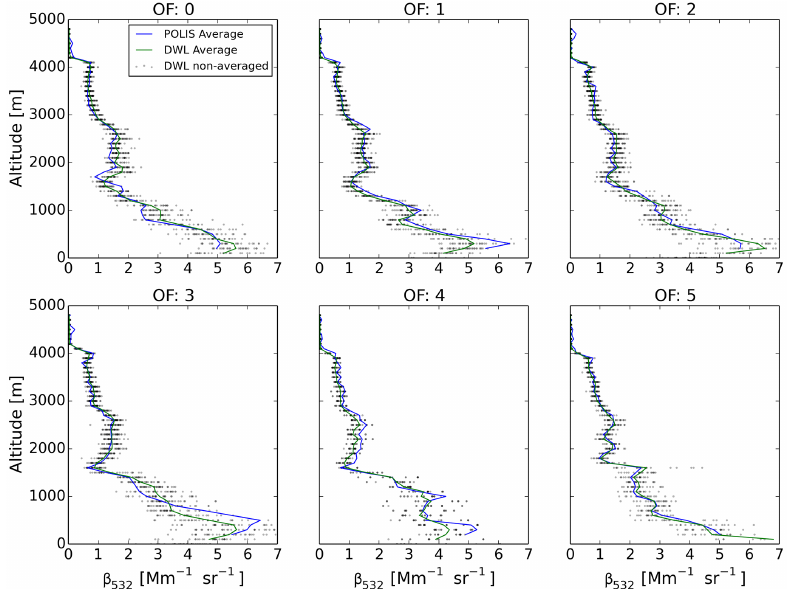
Figure 15. Comparison of the non-averaged (grey dots) and averaged (green) backscatter coefficient profiles corresponding to the retrieved data for the flight on the 26 June and the averaged profiles measured by POLIS (blue) during the Falcon overflights (OF).